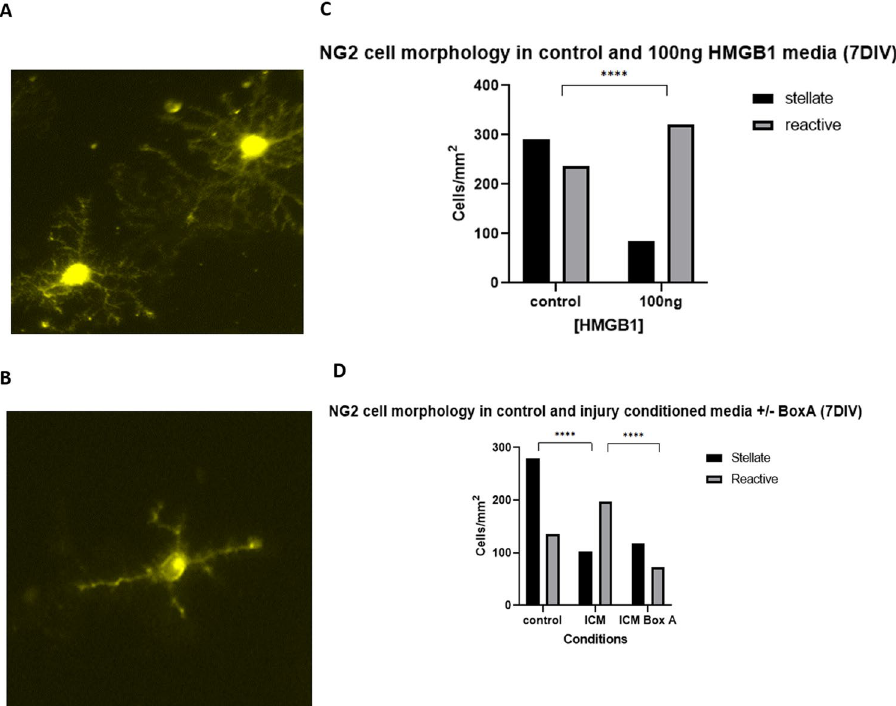
Figure 5. BoxA blocks ICM-induced shift in NG2 cells from stellate to reactive morphology. ( A ) Representative images of NG2 + cells in experimental cultures in a resting, stellate morphology. Note the radial pattern of numerous processes emerging from a homogenously stained cell body. ( B ) Representative images of NG2 cells in experimental cultures in a reactive morphology. Note the linear pattern of a much-reduced number (2–4) of processes emerging from a heterogeneously stained, swollen cell body. ( C ) In the presence of 100 ng/ ml disulphide HMGB1, There were a significantly higher proportion of reactive cells (Chi-square 110.4, 1; p < 0.0001). ( D ) in the presence of injury conditioned media, there was again a significantly increased proportion of NG2 + cells with a reactive morphology (Chi-square 77.73; 1; p < 0.0001). Furthermore, addition of BoxA to ICM cultures reduced the proportion of reactive cells to that of control cultures (Chi-square 82.72, 2; p value < 0.0001). For comparisons between two different conditions, a two-sided Chi 2 test was used in panels C-D. p values of < 0.05 were considered significant (* p < 0.05; ** p < 0.01; *** p < 0.001; **** p < 0.0001). cNSPCs = rat cortical neural stem cell progenitors; DIV = days in